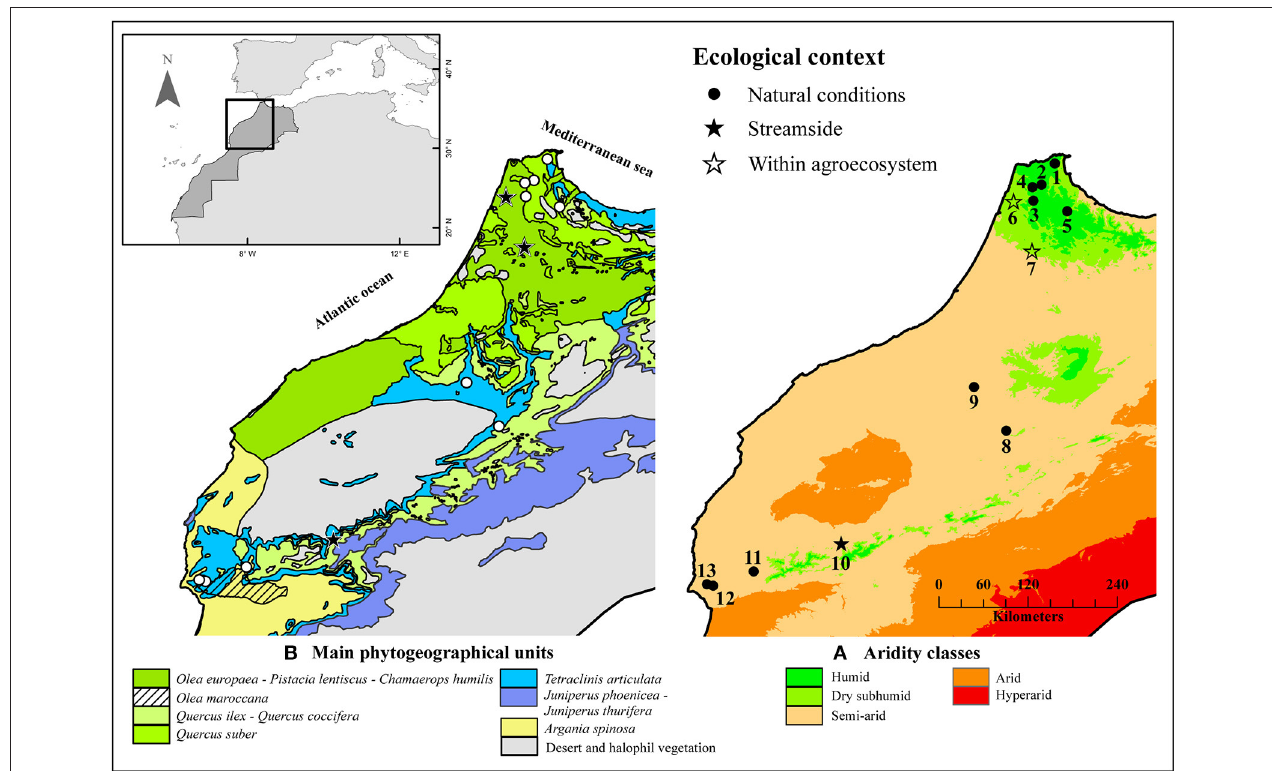
FIGURE 1 | Biogeographical and bioclimatic context of Olea europaea L. populations (wild olive or oleaster and Moroccan olive) from which the wood samples were collected and analyzed ( Kassout et al., 2019). (A) Aridity classes and (B) phytogeographical units of the studied